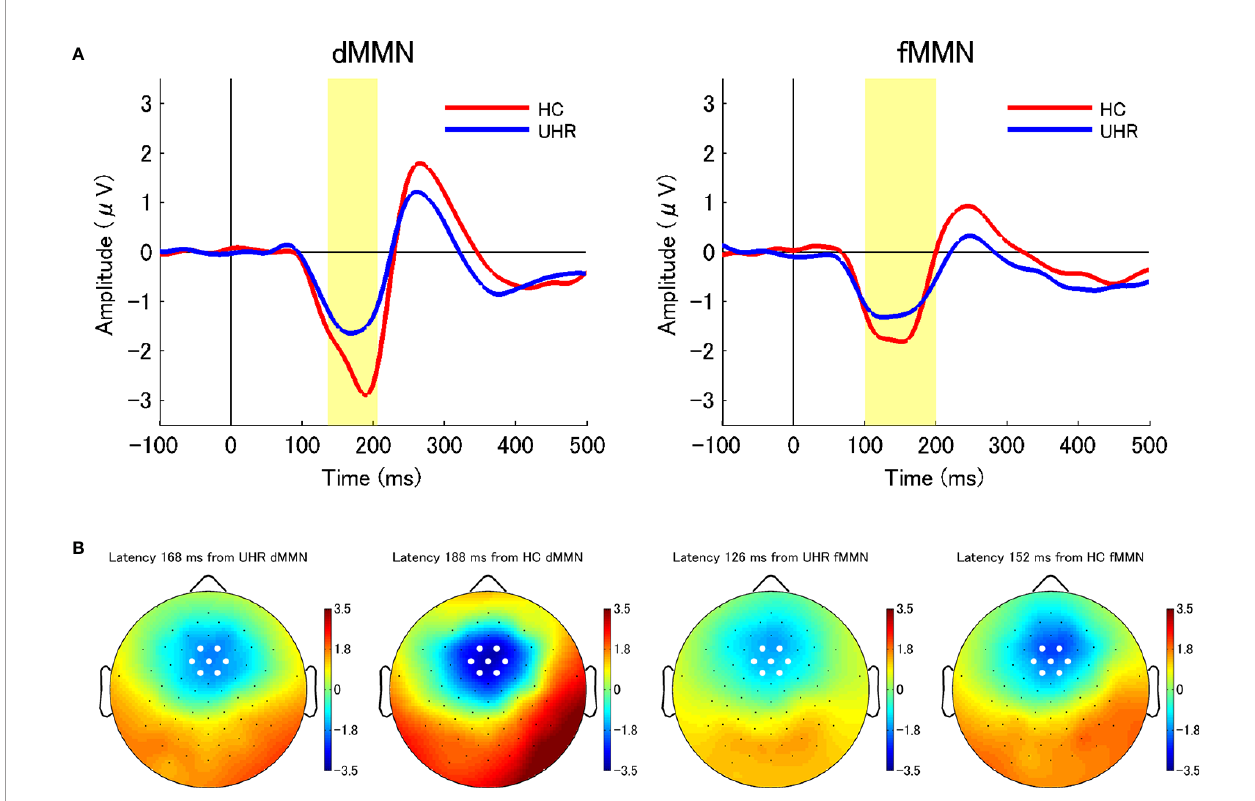
FIGURE 1 | (A) The average waveforms for duration mismatch negativity (dMMN; left) and frequency mismatch negativity (fMMN; right) at the seven electrodes around the frontocentral electrode (FCz) in individuals at ultra-high risk for psychosis (UHR; blue line) and healthy control (HC) participants (red line). Between-group differences in the dMMN amplitudes were signi fi cant at the.01 level. (B) Two-dimensional topographic maps at the latency of peak amplitudes of dMMN (left) and fMMN (right) in both groups. The latency of peak amplitudes were 168 ms (dMMN, UHR), 188 ms (dMMN, HC), 126 ms (fMMN, UHR), and 152 ms (fMMN, HC). White circles represent the seven electrodes around the